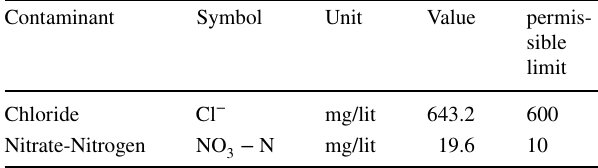
is variable, and minimizing the mean of the pumping rate